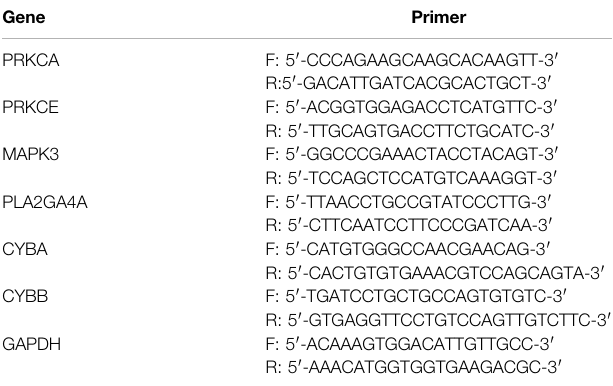
TABLE 1 | Primers used for quantitative real-time